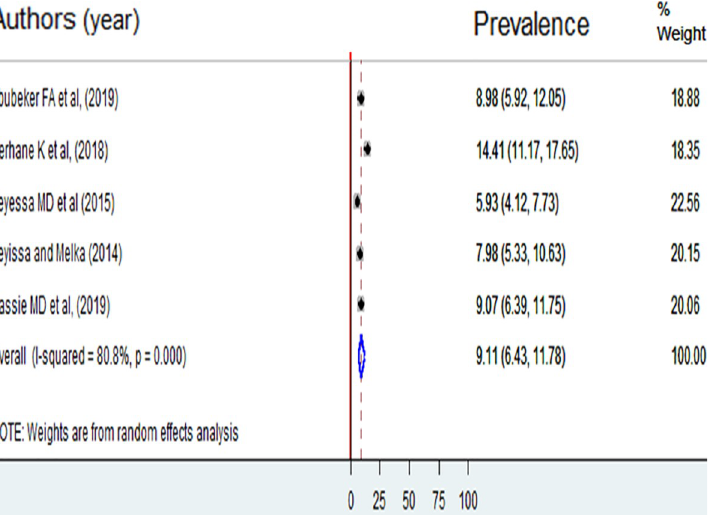
Fig 4. Prevalence of unmet need for limiting among reproductive-age women living with HIV in Ethiopia, 2013 to 2018.